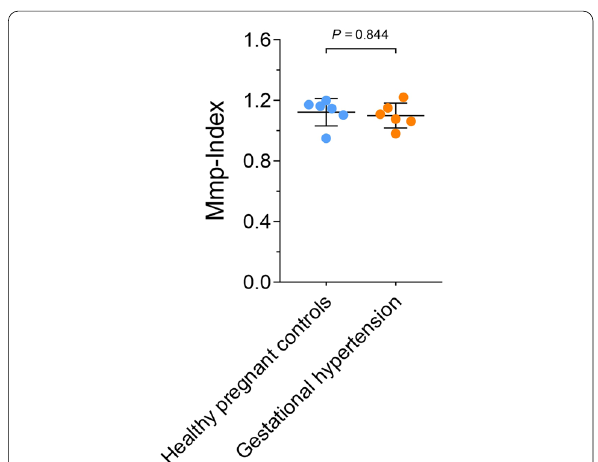
Fig. 4 Comparison of platelet Mmp-Index between patients with isolated gestational hypertension and normal pregnancy. Platelet Mmp-Index of patients with isolated gestational hypertension (n 6) = in the absence of preeclampsia showed no statistical difference to pregnant control patients (p =